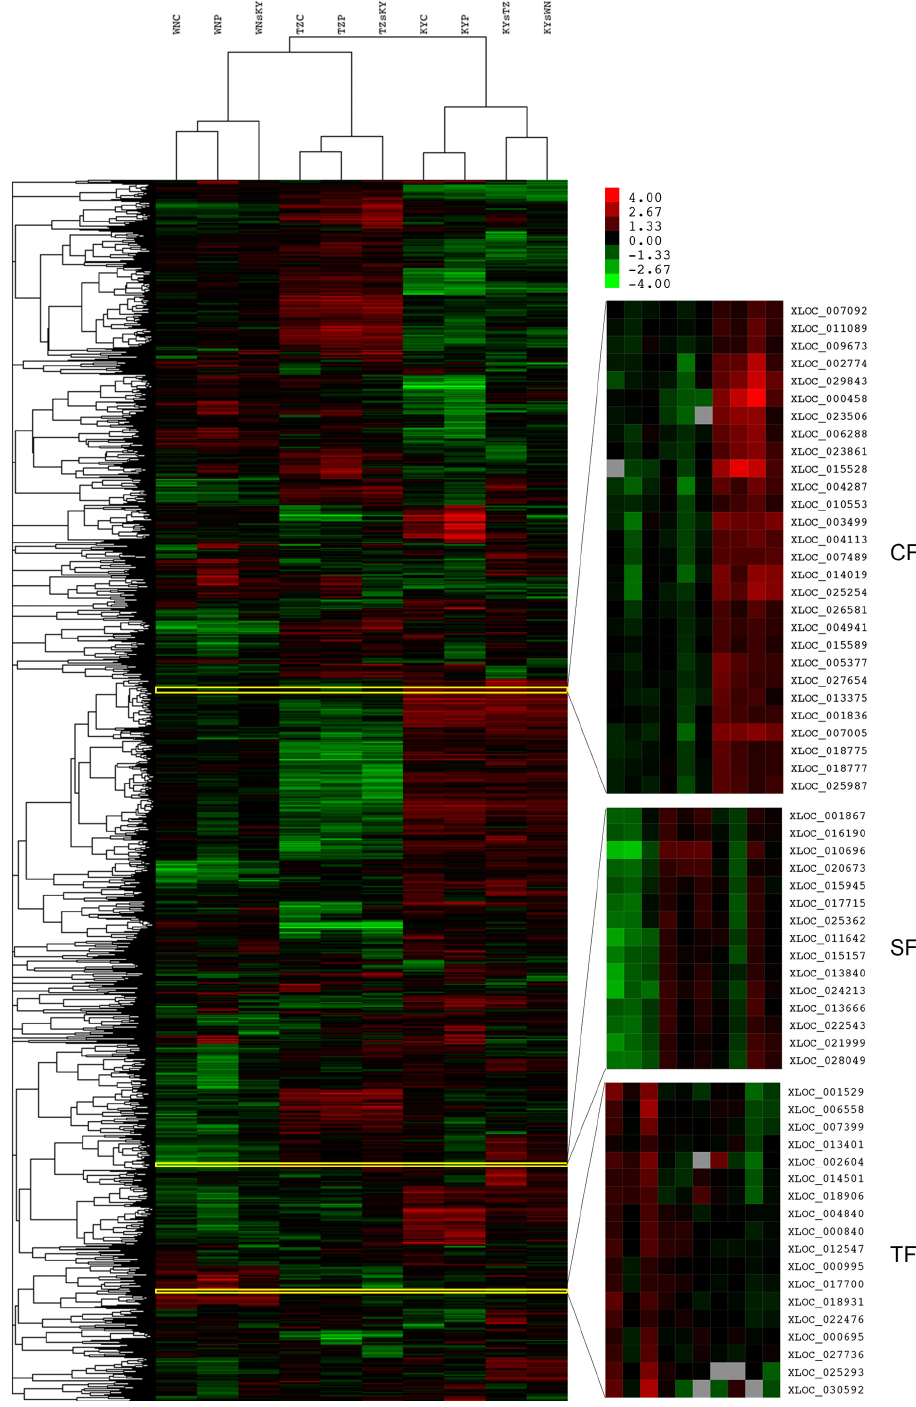
Figure 3. Hierarchical clustering and Treeview visualization of all DEGs. Ten samples from three different cultivated regions with soil exchange and tillage treatments were collected were subjected to RNA-seq, revealing a total of 6,386 DEGs among treatment groups (i), (iii), and (v). Log2 values were used to cluster all the DEGs in Cluster 3.0 using uncentered correlation and the complete linkage method. Results were visualized using Treeview. Left heatmap represents global visualization of all the DEGs, right gene cluster are representative CF-, SF- and TF-specific DEGs. Red indicates genes that are up-regulated, green indicates genes that are